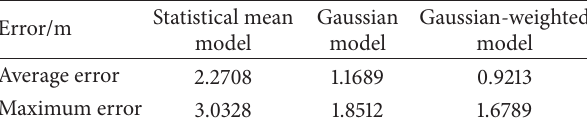
Table 1: Comparison of the ranging